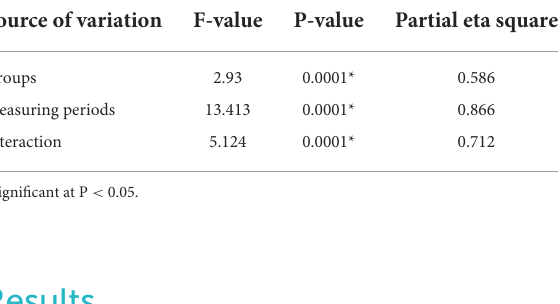
TABLE 2 The 3 × 2 mixed-design Multivariate Analysis of Variance (MANOVA) for the tested variables at the two measuring periods among the tested